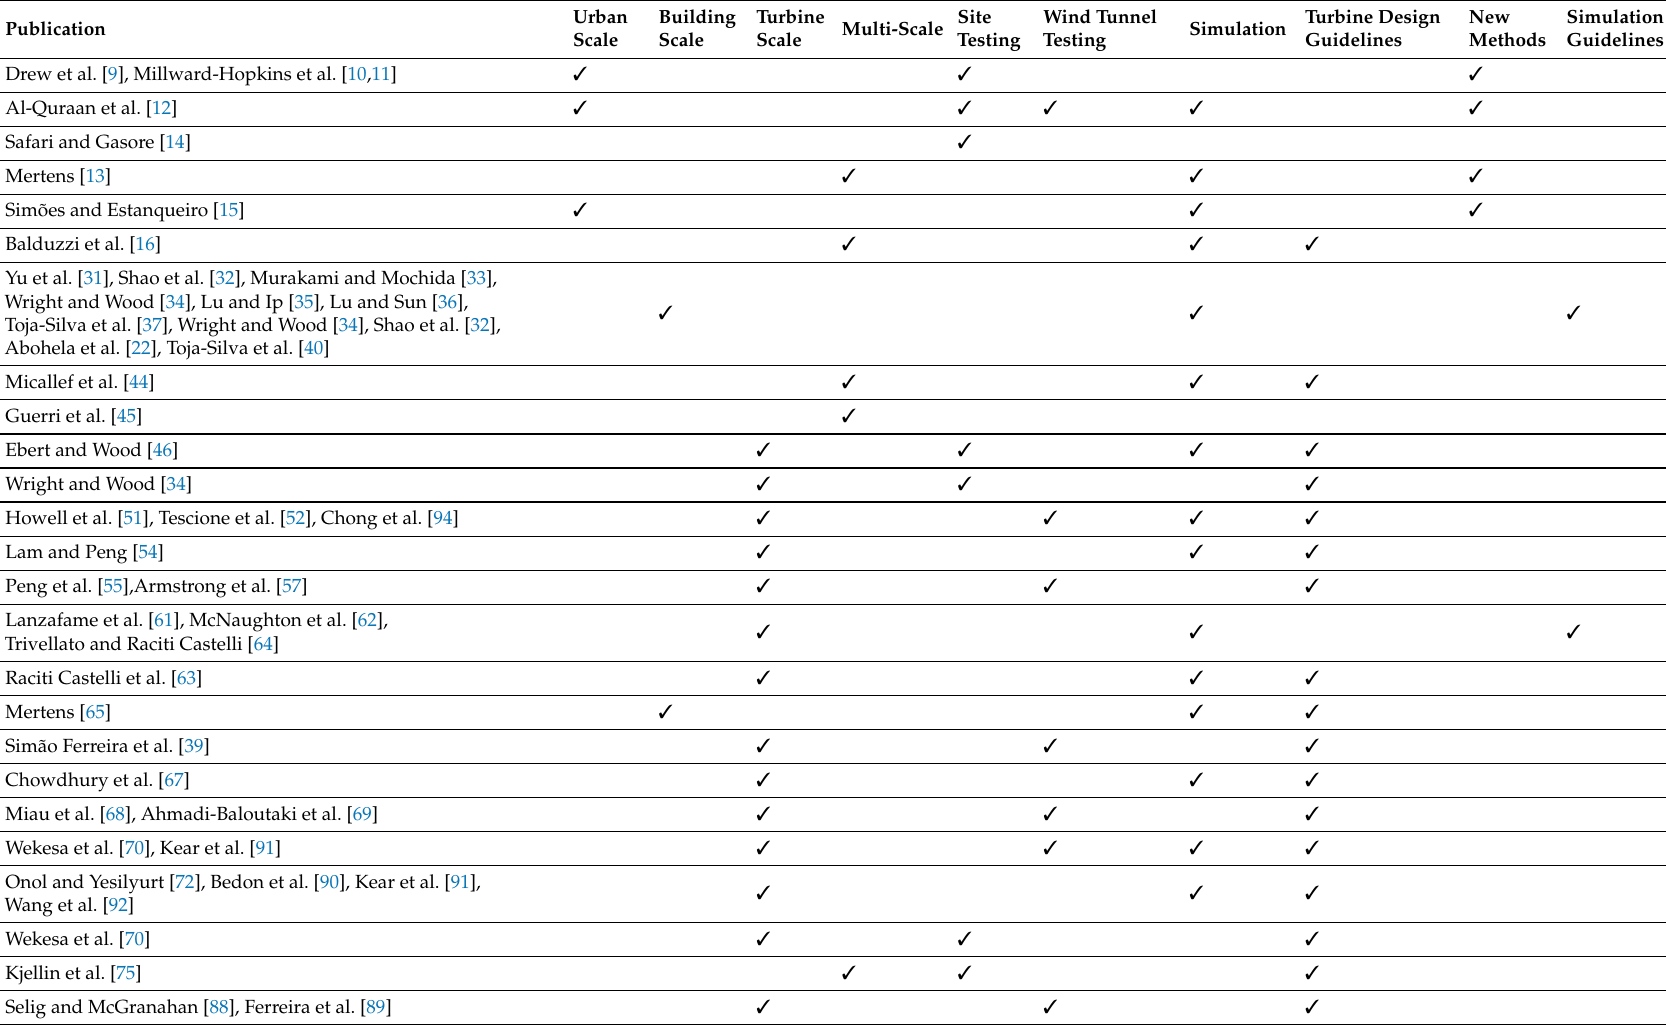
Table 3. Topics addressed by various literature sources in the field of urban wind energy